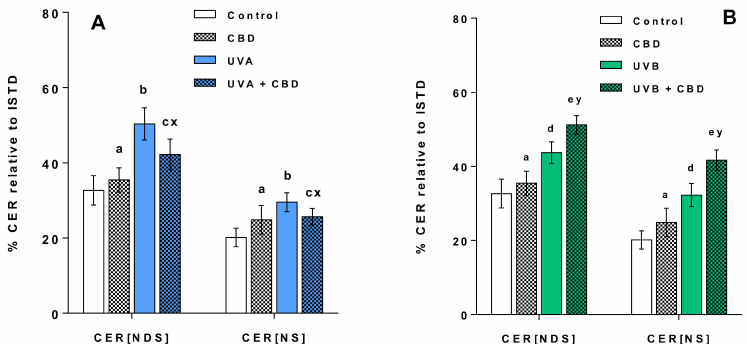
Figure 6. Changes in relative ceramide (CER) content related to the internal standard of each ceramide class within CER[NDS] and CER[NS] classes in keratinocytes isolated from the skin of control rats (Control) and rats irradiated with UVA (increasing doses from 0.5 to 5 J / cm 2 for 4 weeks). These cells were not treated or treated with CBD (2.5 g CBD in 100 g petrolatum) panel ( A ); the skin of control rats (Control) and rats irradiated with UVB (increasing doses from 0.02 to 2 J / cm 2 for 4 weeks). These cells were not treated or treated with CBD (2.5 g CBD in 100 g petrolatum) panel ( B ). The following groups of keratinocytes were examined: Control, CBD, UVA, UVA + CBD, UVB and UVB + CBD; values are mean ± SD, p < 0.05; (a), CBD vs. control; (b), UVA vs. control; (c), UVA + CBD vs. control; (d), UVB vs. control; (e), UVB + CBD vs. control; (x), UVA + CBD vs. UVA; (y), UVB + CBD vs.